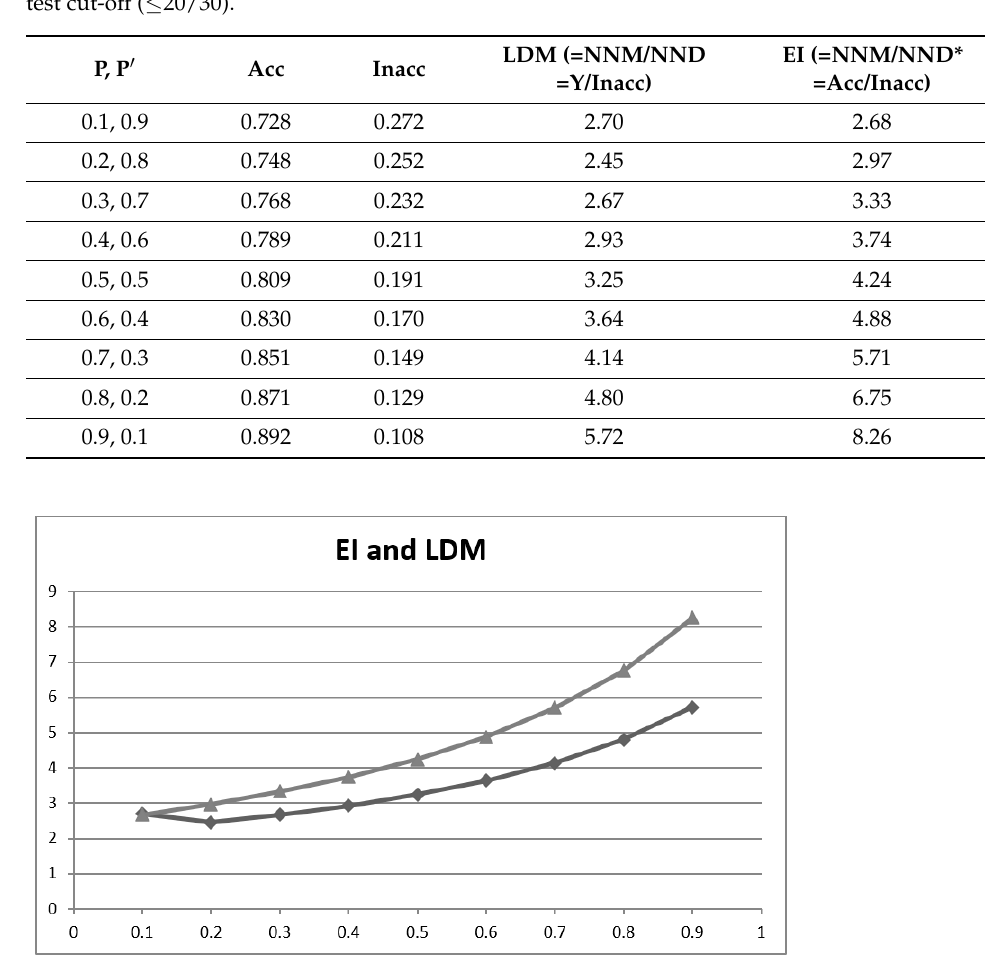
Figure 3. Plot of efficiency index (EI; upper line, triangles) and of likelihood to be diagnosed or misdiagnosed (LDM; lower line, diamonds) values (y axis) vs. prevalence of dementia (x-axis).